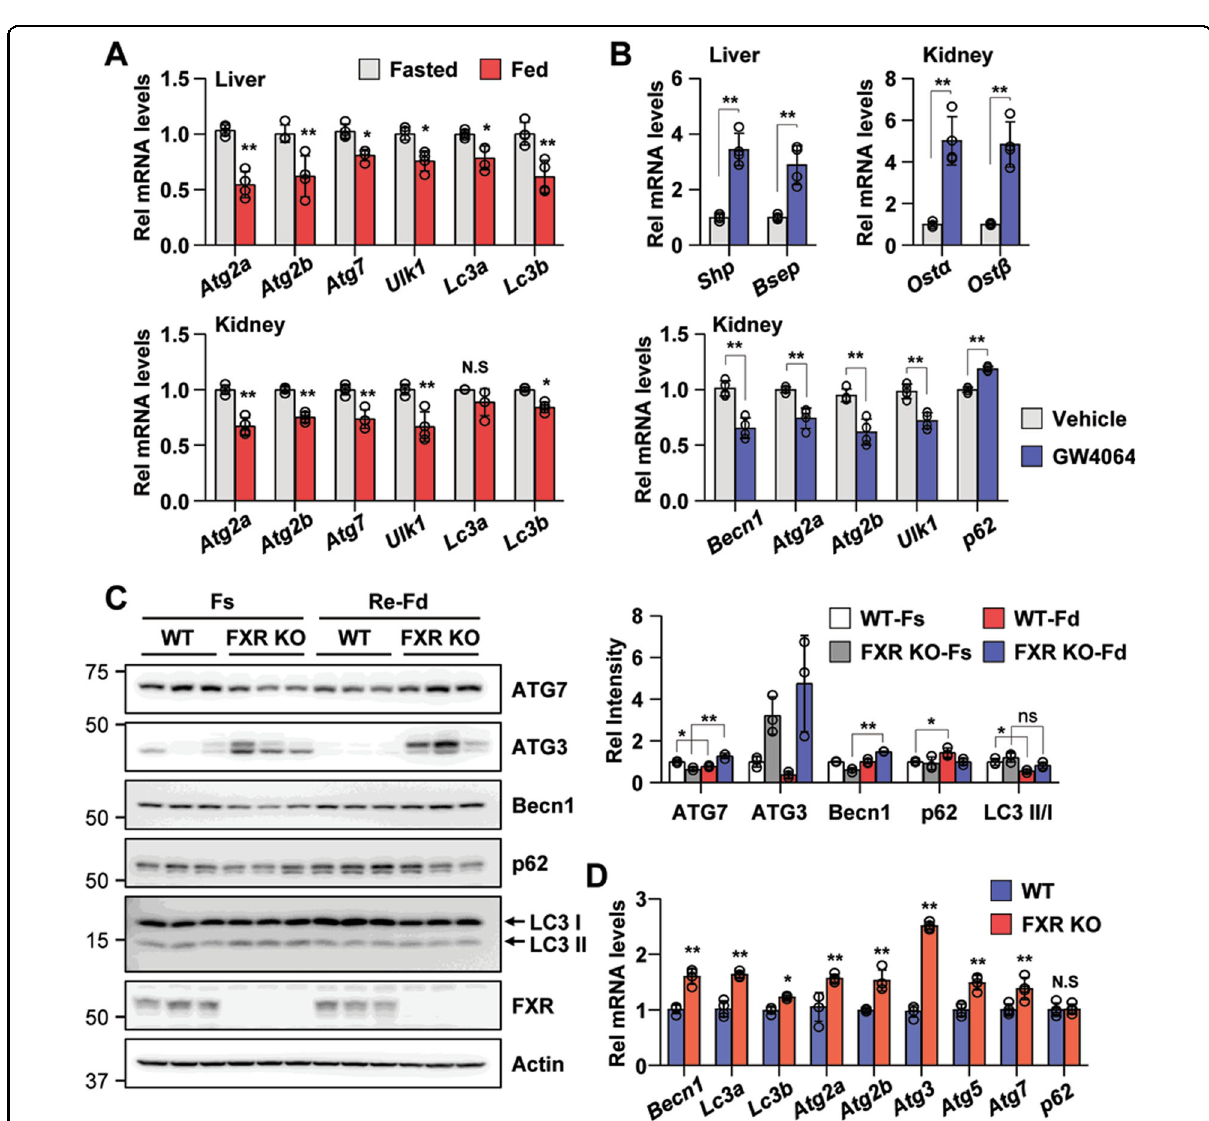
Fig. 2 FXR inhibits renal autophagy by feeding and GW4064. A , B Wild-type mice were fasted for 12 h at which point were then fed a normal chow diet ( A ) and treated with vehicle or GW4064 for 6 h. The liver and kidneys were collected, and the mRNA levels of the indicated genes were measured by qRT-PCR. The values for fasted or vehicle treatment were set to 1 ( n = 4). C Wild-type and FXR knockout mice were fasted and refed, and the kidneys were collected. The levels of autophagy-related proteins and FXR were detected by immunoblotting. The relative levels are shown ( n = 3). The level of each protein, including actin, in the wild-type fasting sample was set to 1. D Wild-type and FXR knockout mice were fasted for 6 h, and the kidneys were collected. The mRNA levels of the indicated genes were measured by qRT-PCR. The values for wild-type mice were set to 1 ( n = 4). All values are presented as the mean ± SD. Statistical signi fi cance was measured using one-way or two-way ANOVA with the Bonferroni post- test. * P < 0.05, ** P < 0.005, ns statistically not signi fi cant, WT-Fs wild-type fasting, WT-Fd wild-type feeding, FXR KO-Fs FXR knockout fasting, FXR KO-Fd FXR knockout